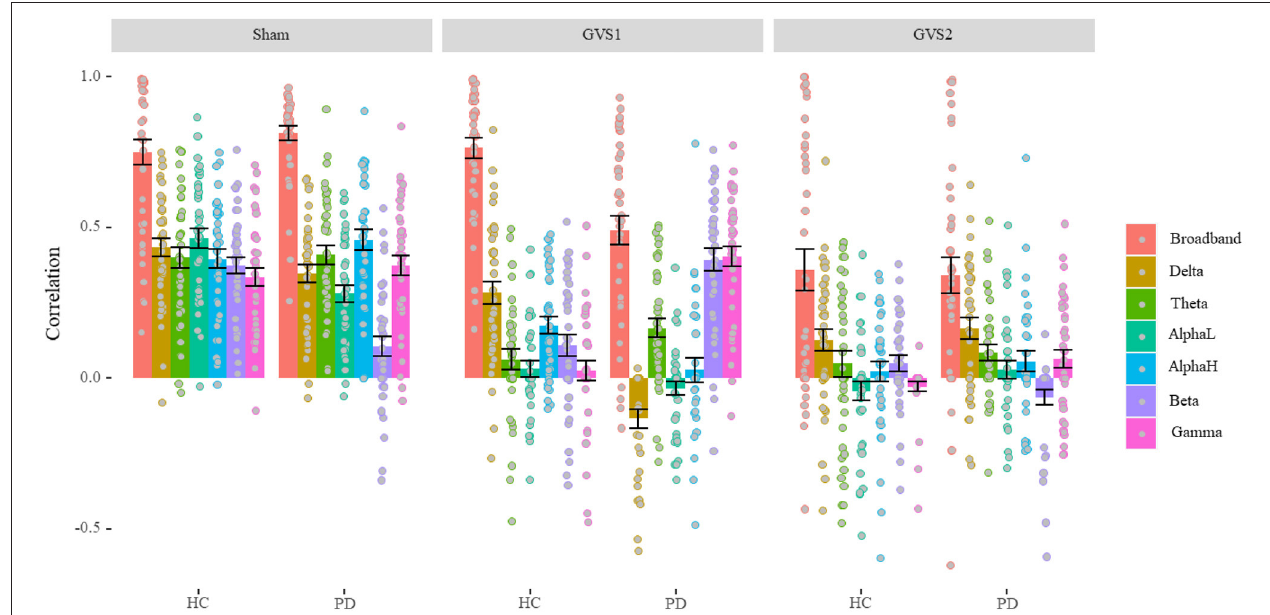
FIGURE 3 | LASSO correlation performance (Model Comparison). Under GVS stimuli, the overall performance of the models is dropped except for broadband in healthy controls (HC), and beta and gamma models in the PD population under models only under GVS1. In sham conditions, band models gave almost the same level of performance except for the beta model in the PD population that gave the lowest performance. PD, Parkinson’s disease; HC, healthy controls. Sham: No stimulation, GVS1: 50–100Hz; GVS2: